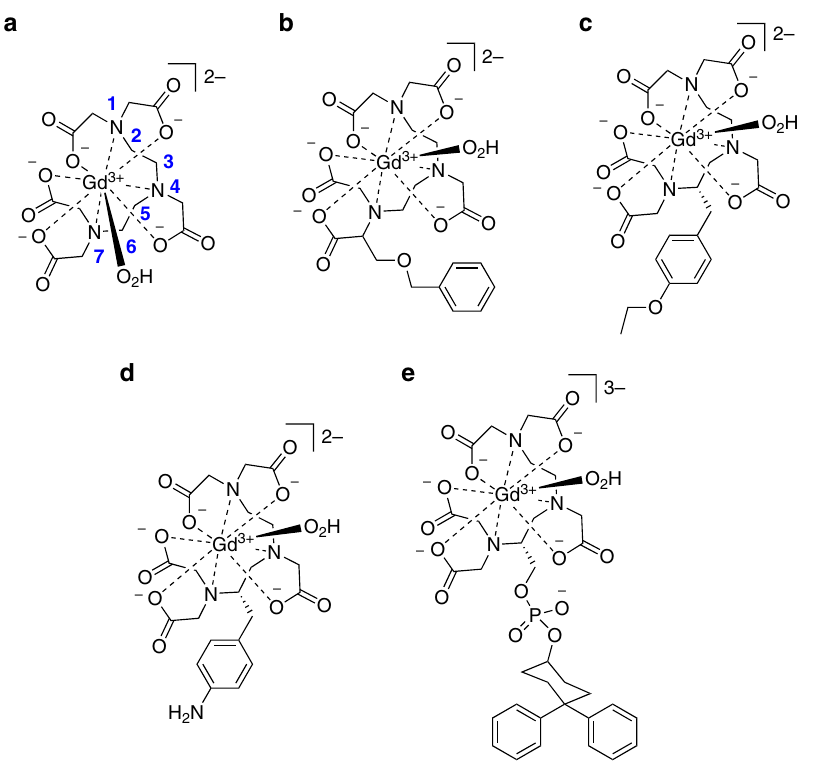
Fig. 7 Acyclic ligands where chirality has been introduced into the ligand framework. a [Gd(OH 2 )(dtpa)] 2 − , where the central nitrogen atom N4 is chiral upon binding to Gd 3 + but inversion is prohibited after complexation. b [Gd(OH 2 )(bopta)] 2 − , where substitution on the acetate ligand arm with a benzyl oxymethyl group facilitates chirality. c [Gd(( S )-eobdtpa)] 2 − and d [Gd((S)pNH 2 bz-dtpa)] 2 − , where chirality is introduced by bulky substitution on the ligand backbone. e The Gd(III) complex component of MS-325, where the steric bulk of the phosphodiester moiety encourages selectivity in isomer formation. Stereochemistry is added where